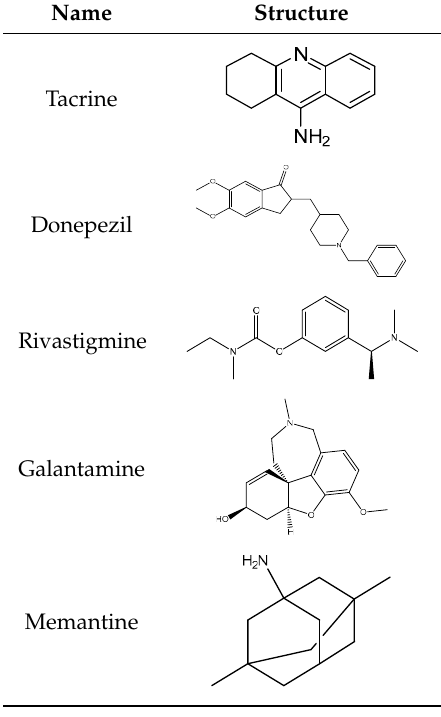
Table 1 . Approved drugs for the treatment of Alzheimer’s disease.